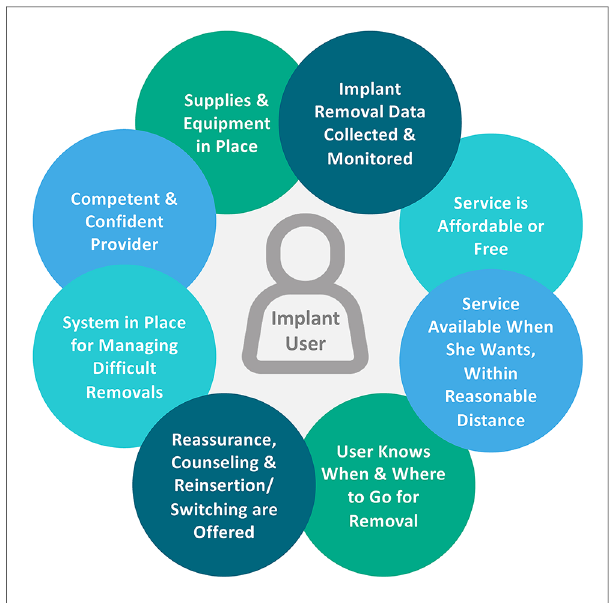
FIGURE 1 Client-centered conditions for ensuring access to quality implant removal (via Implant Removals Task Force, with